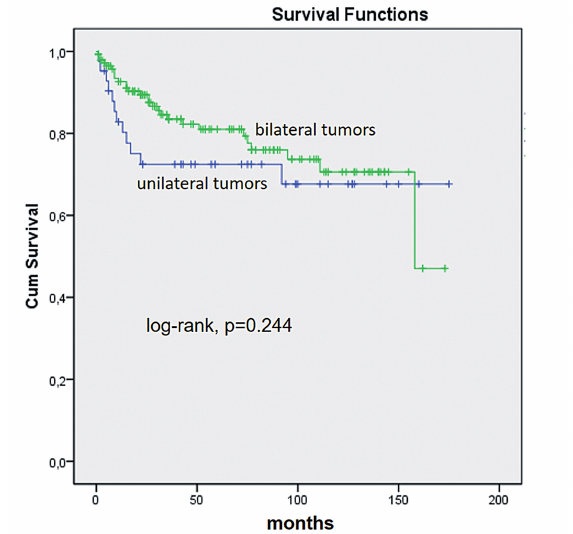
Figure 2 - Kaplan - Meier product limit analysis shows time to PSA biochemical progression - free outcome by laterality considering total tumor extent. Cum,